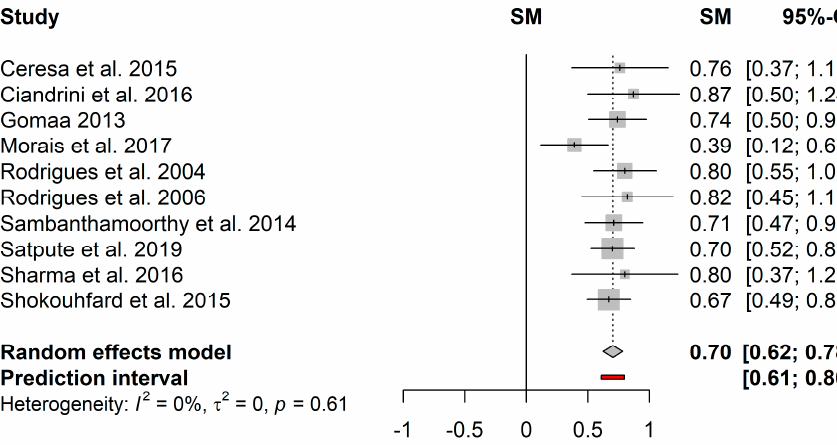
Figure 4. Forest plot of the pooled effect estimates for the proportion of biofilm reduction induced by biosurfactants. The vertical dashes represent the effect estimate, and the horizontal line is the respective confidence interval at 95% (95%–CI) obtained for each study. Gray squares represent the standard deviation of each study, while the gray diamond represents the pooled effect estimates. The red bar represents the predictive interval. Heterogeneity test: I 2 – I 2 test; τ 2 –Tau-squared test.